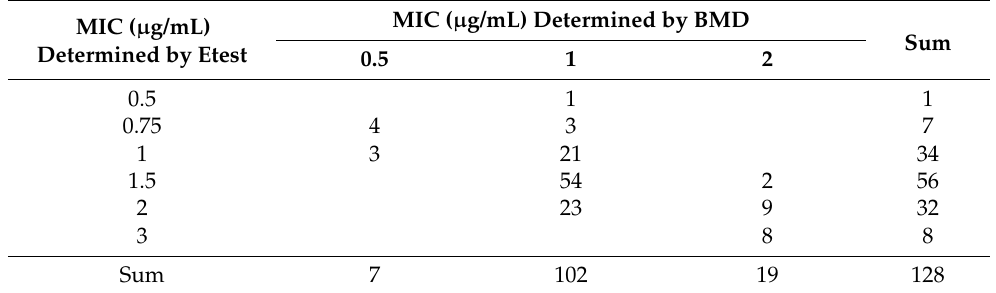
Table 1. Distribution of vancomycin MICs determined by Etest compared to broth microdilution (BMD). MIC ( µ g/mL)